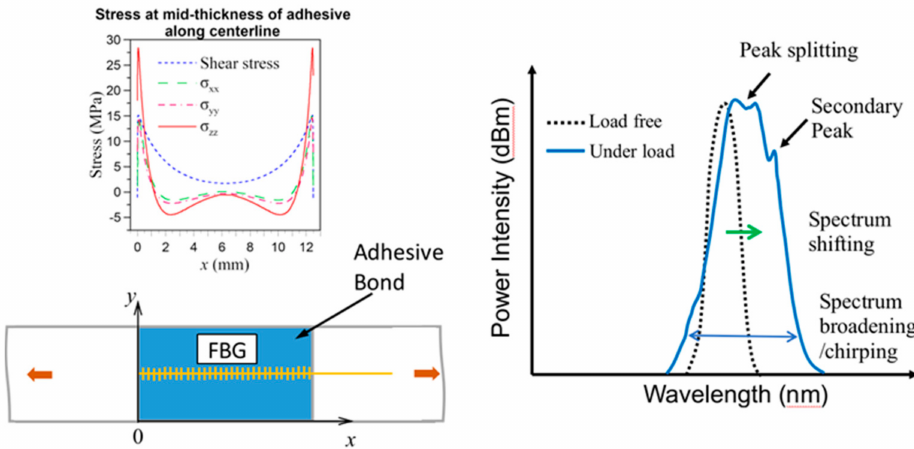
Figure 1. Schematic diagram showing the stress distribution along the centerline of the adhesive joint and its possible resulting effects on an FBG embedded at that